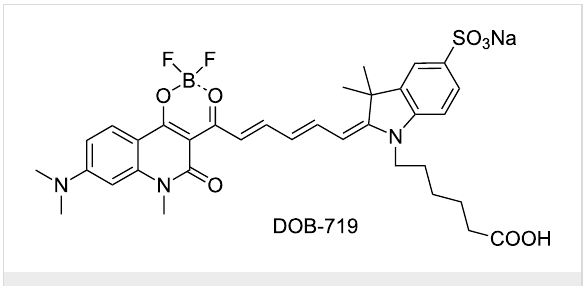
Figure 1: The chemical structure of